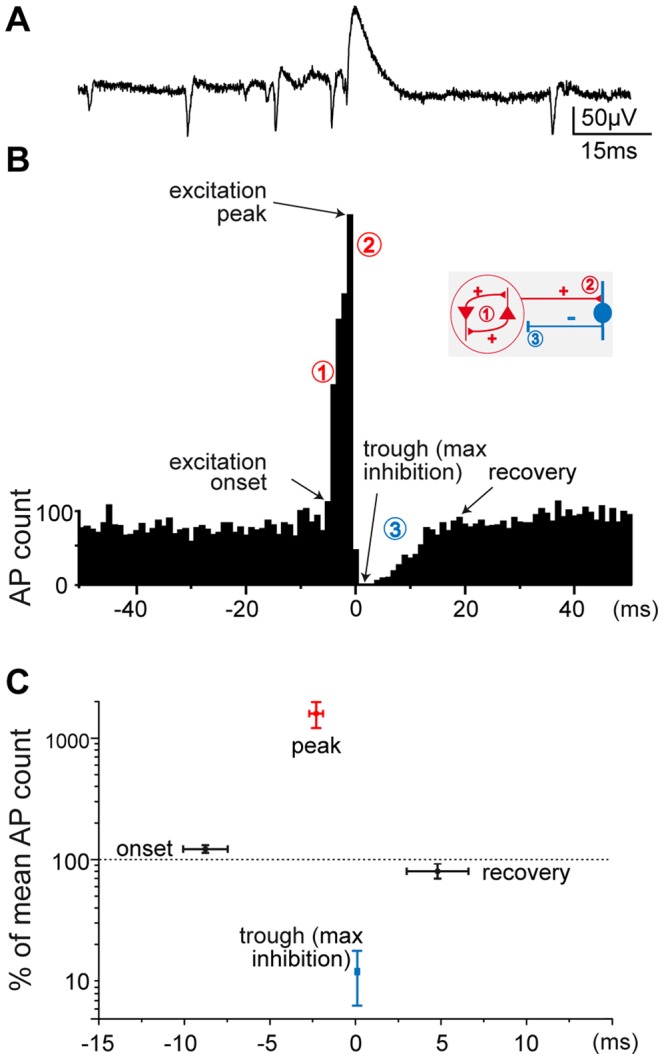
Recurrent excitation and inhibition in vitro
.
A. Example trace showing a spontaneous CA3 eIPSP and action potentials. B. Cross-correlogram (from a single representative experiment, in a guinea pig) between in vitro recorded multi-unit activity and eIPSP-peak time (used as reference). Time scales are similar in A and B, taken from the same recording, and eIPSP-peaks aligned for illustration. Time bin, 1 ms. Onset, first of pre-eIPSP time bins above mean +2SD; recovery, last of post-eIPSP time bins below mean - 2SD. C. Diagram illustrating firing rates (normalized and averaged across 9 slices from 3 guinea pigs, 3 mice and 3 rats, mean ± SEM, base line level = 100%) at onset, peak, trough, and recovery time points, as indicated in B. Note increased multi-unit discharge in the 10 ms prior to eIPSP, and the strong inhibition (trough, max inhibition) that follows. Inset, schematic illustration of the recurrent excitatory/inhibitory loop: (1) recruitment of interconnected pyramidal cells initiate collective discharge through recurrent excitation, (2) integration of excitation on a 10–15 ms time scale activates discharge of local interneurons, resulting (3) in perisomatic eIPSP and inhibition of pyramidal population activity.